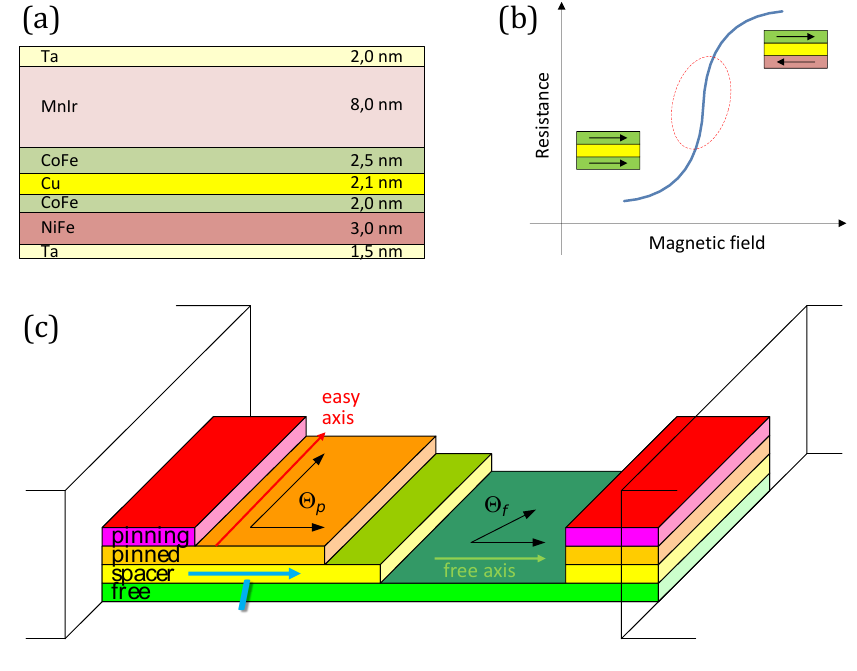
Figure 1. Description of the function mechanism in spin